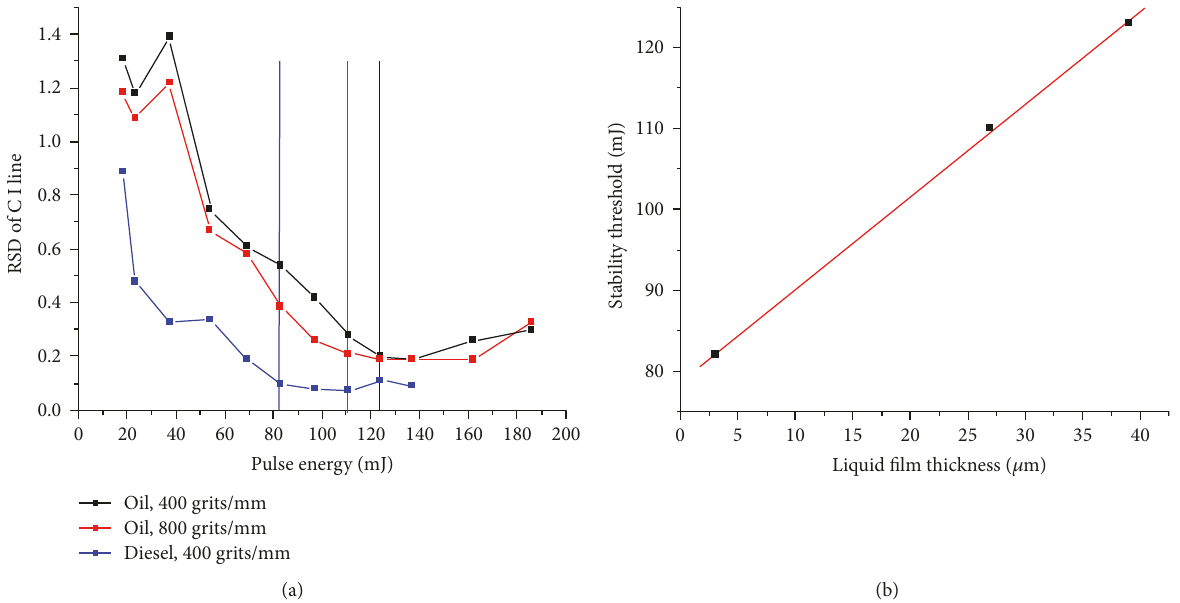
Figure 9: (a) RSD of C I line as a function of the laser energy at rotation speed of 40rpm, measured on diesel (blue) and on peanut oil for two polishing grades of the substrate; the energies where the signal becomes stable are indicated with vertical lines. (b) The threshold energy for stable C I line intensity as a function of the estimated liquid fi lm thickness.